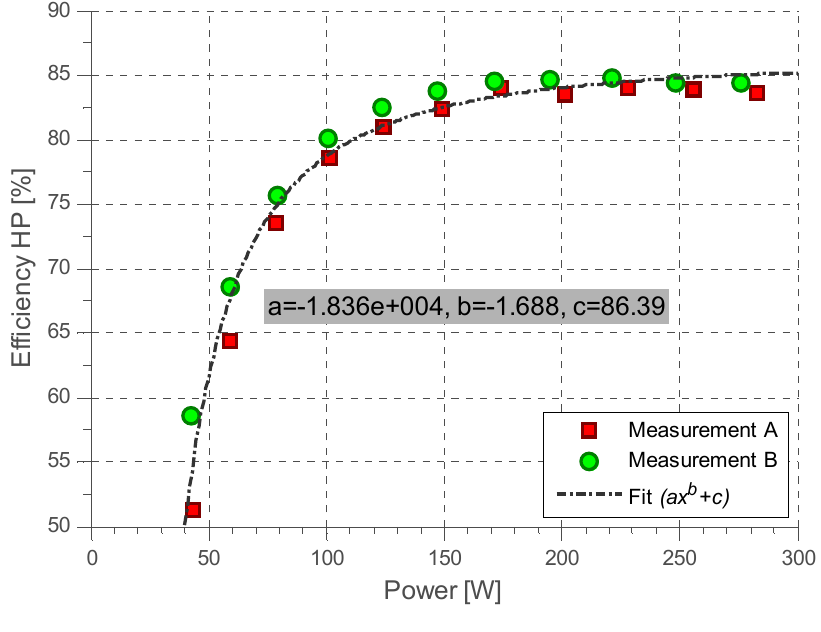
Figure 14. Efficiency of the HP side of the driveline versus the load power, i.e. , power delivered from the